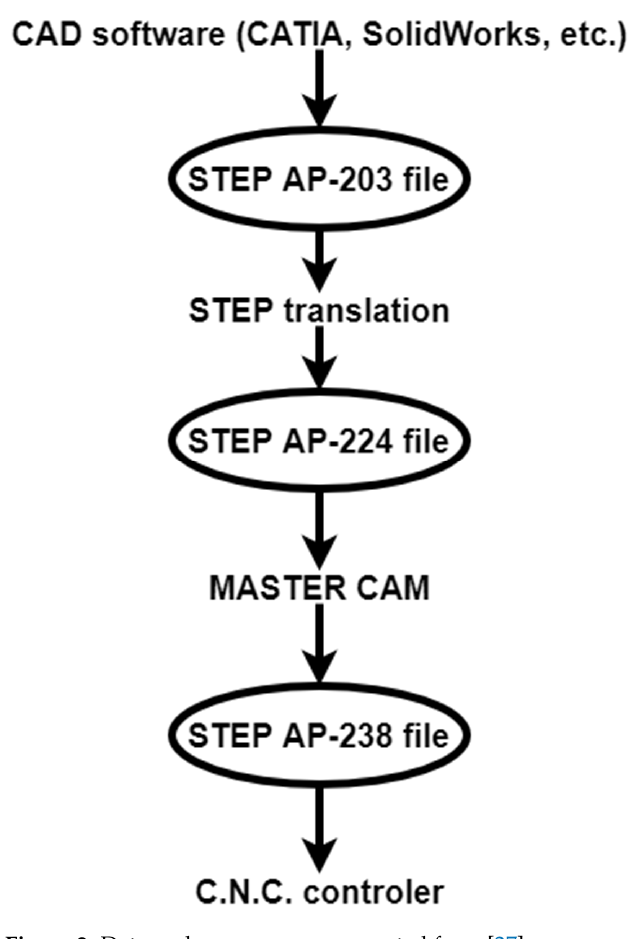
Figure 2. Data exchange process, recreated from [27].